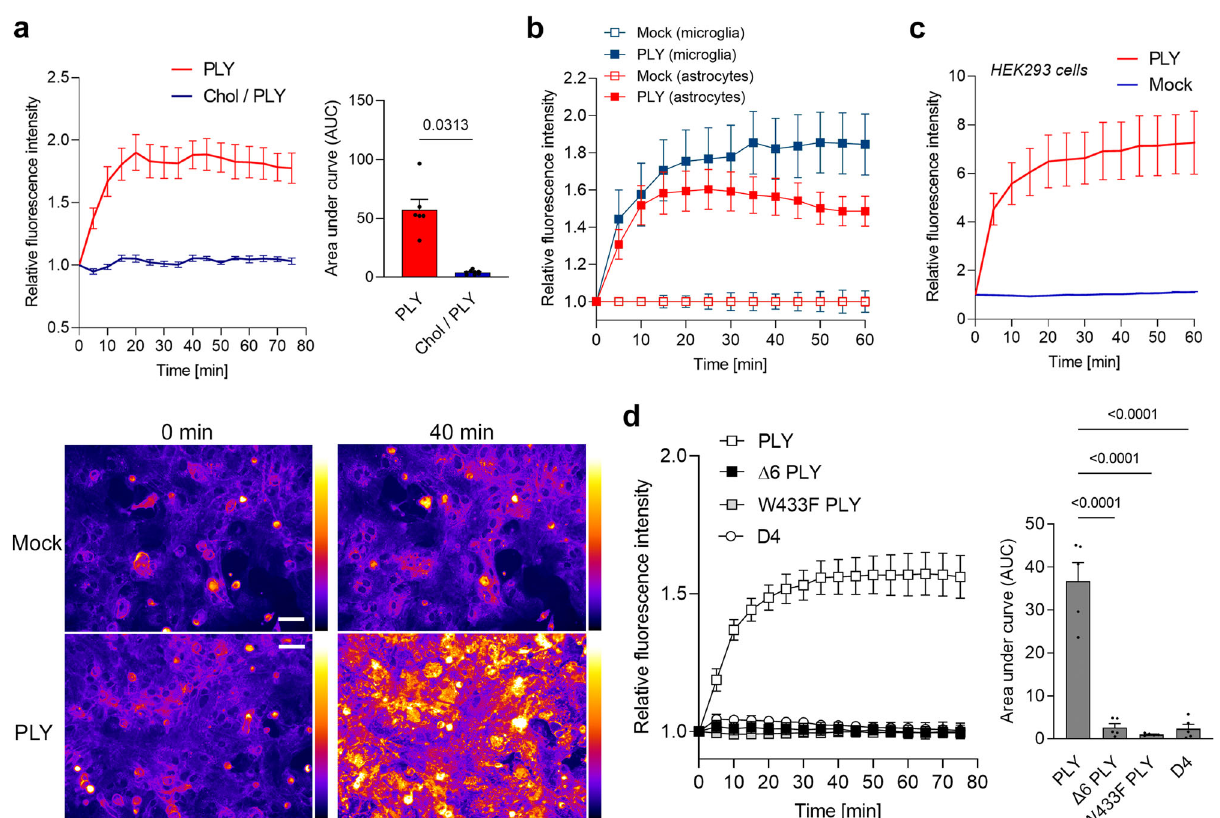
Fig. 3 | Recombinant PLY enhances endocytosis in a pore-dependent manner. a Recombinant PLY (2 HU/ml) enhances endocytosis (FM 4-64 assay), and the process is blocked by preincubation of the toxin with cholesterol. Curves are normalized to the mock-treated cells. Representative images demonstrate